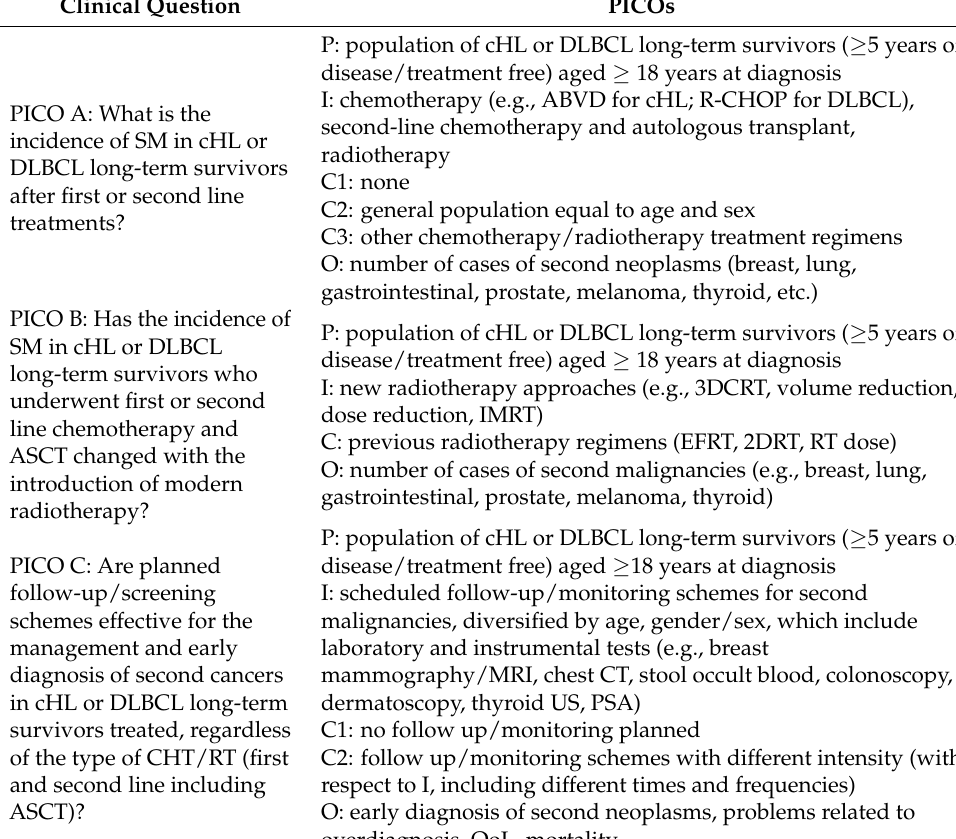
Table 1. Clinical questions and corresponding PICOs addressed by this systematic review. Clinical